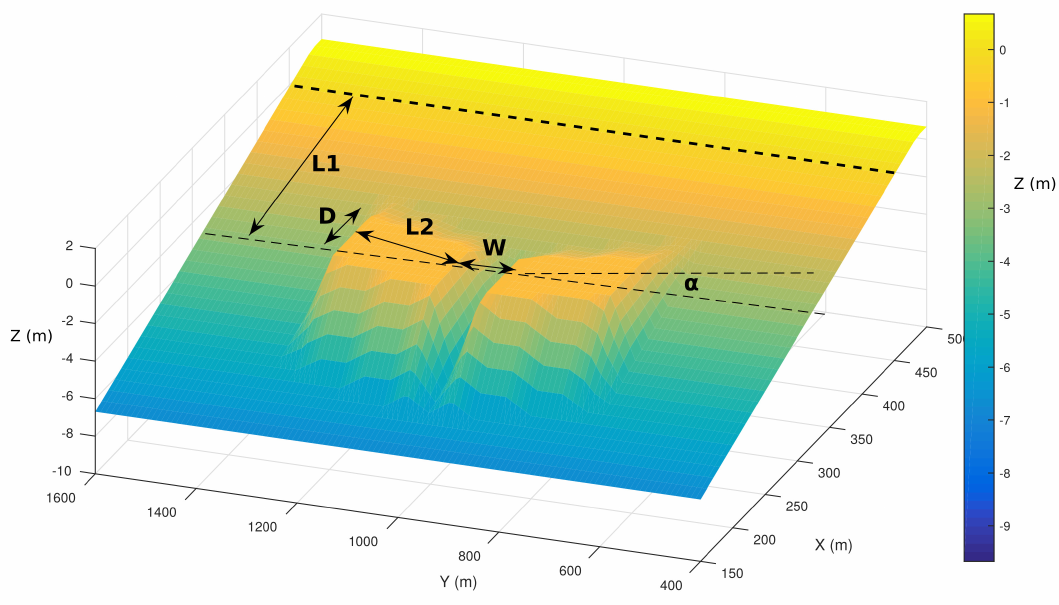
Figure 2. Numerical bathymetry and geometrical